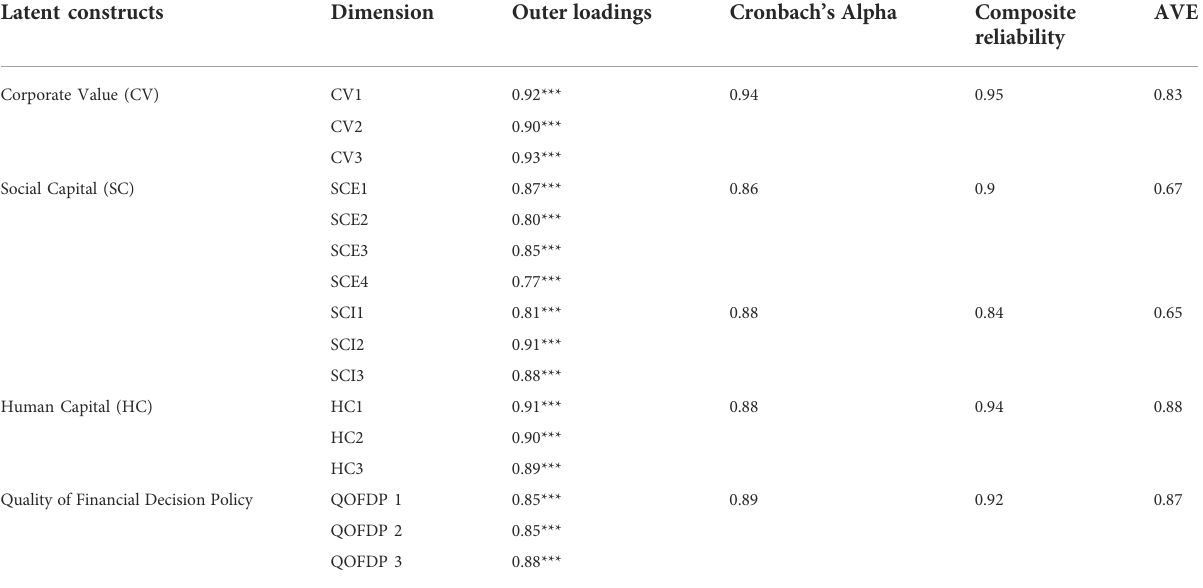
TABLE 3 Convergent validity and